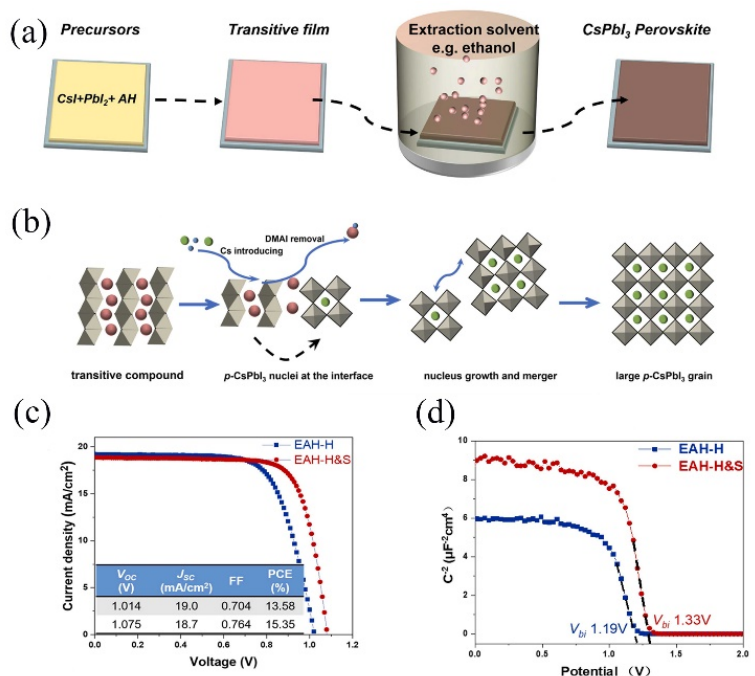
Figure 10. ( a ) Schematic illustration of EAH-S process. ( b ) Formation mechanism of CsPbI3 (p- CsPbI3) by EAH − S process. ( c ) J–V curves of CsPbIBr 2 C-IPSCs by EAH − H&S and EAH − H. ( d ) Mott- Schottky analysis plots at 10 kHz for CsPbIBr 2 films EAH − H&S and EAH − H. Reproduced with permission [128]. Copyright 2022, Elsevier Inc Publications.